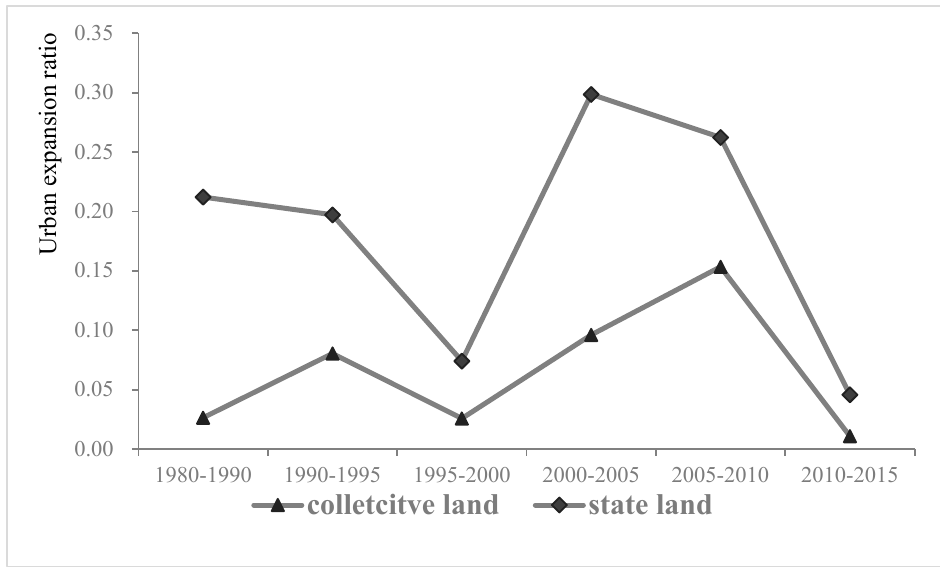
Figure 7. Urban expansion ratio between collective land and state land. (Source: drawn by the au- thors).